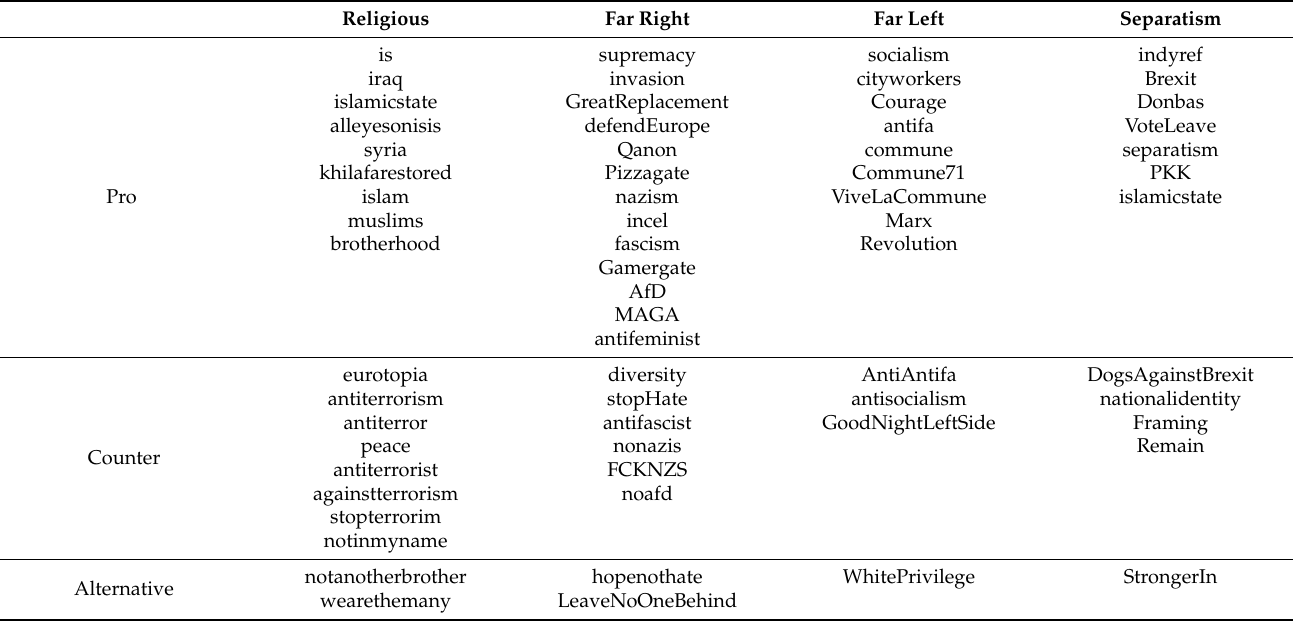
Table 2. Hashtags are used to capture messages organized by ideology and